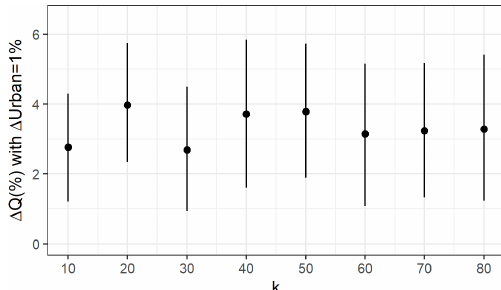
Figure 4. Percentage change in annual maximum discharge ( Q ) caused by a 1% point increase in urban area (Urban) based on dif- ferent numbers of catchment groups ( k ). The error bars are 95% confidence